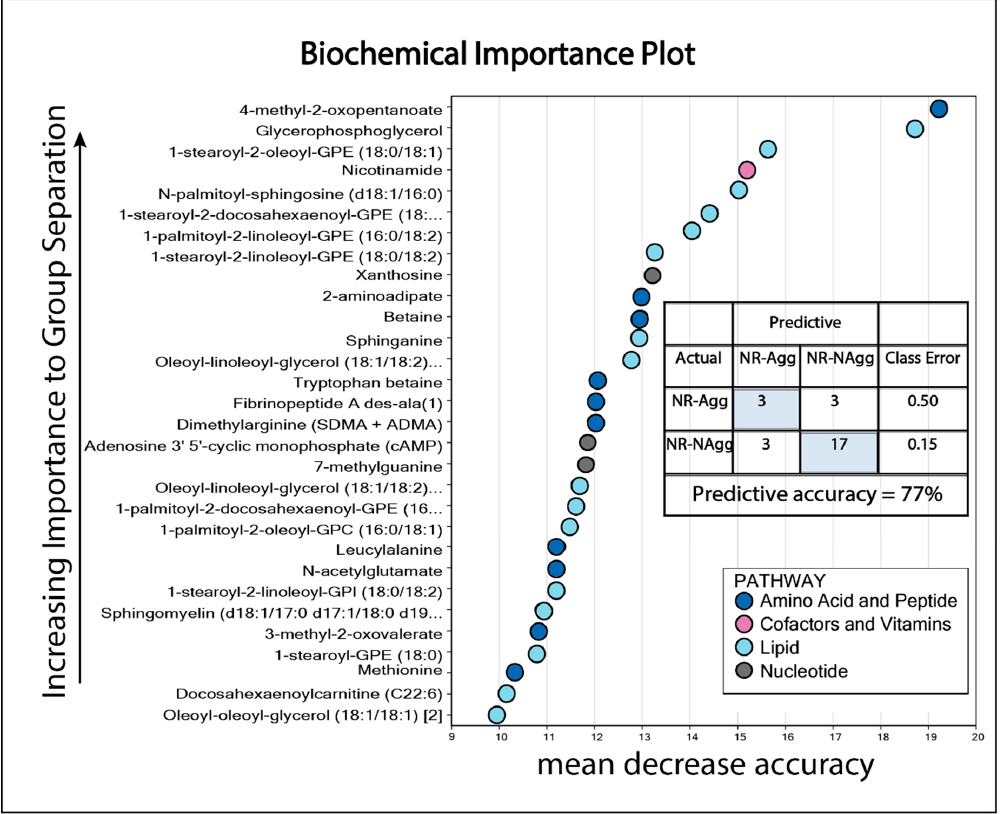
Figure 2. Random forest analysis based on pretreatment serum metabolites when comparing non-responders with rapidly progressive disease versus non-responders with less aggressive disease to antileukemic treatment based on ATRA and valproic acid. The figure shows the 30 top-ranked metabolites from this analysis, which can segregate the two patient groups with a predictive accuracy of 77%. Amino acid and lipid metabolites constituted the majority of the top-ranked metabolites. Color codes for classification of metabolites are shown to the lower right. This analysis included 26 metabolites with a p -value < 0.05 (see Figure 1; six amino acid metabolites, 16 lipid metabolites, and four other metabolites). Abbreviations; NR-Agg, non-responders aggressive disease (i.e., rapidly progressive); NR-NAgg, non-responders non-aggressive disease.